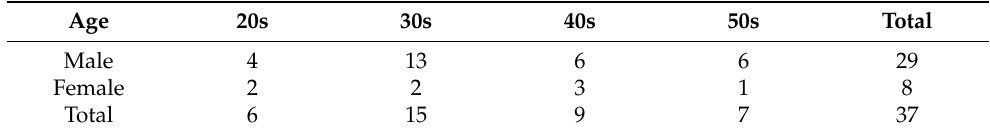
Table 1. Participant age groups by